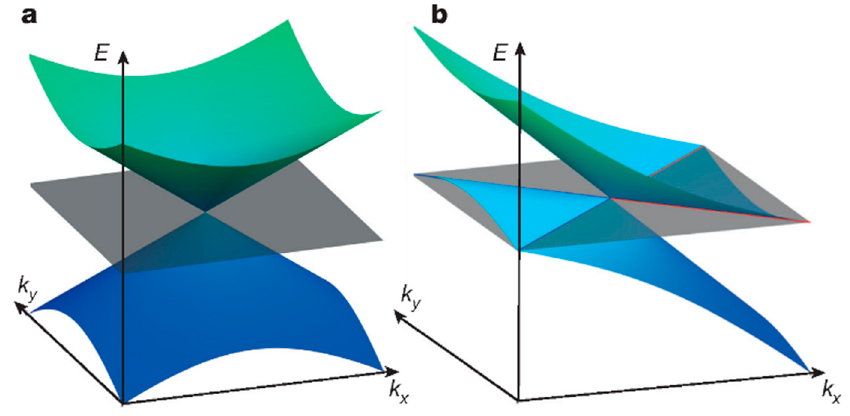
Figure 4. The WP and the Fermi surface of type-I ( a ) and type-II WSM ( b ) [12].